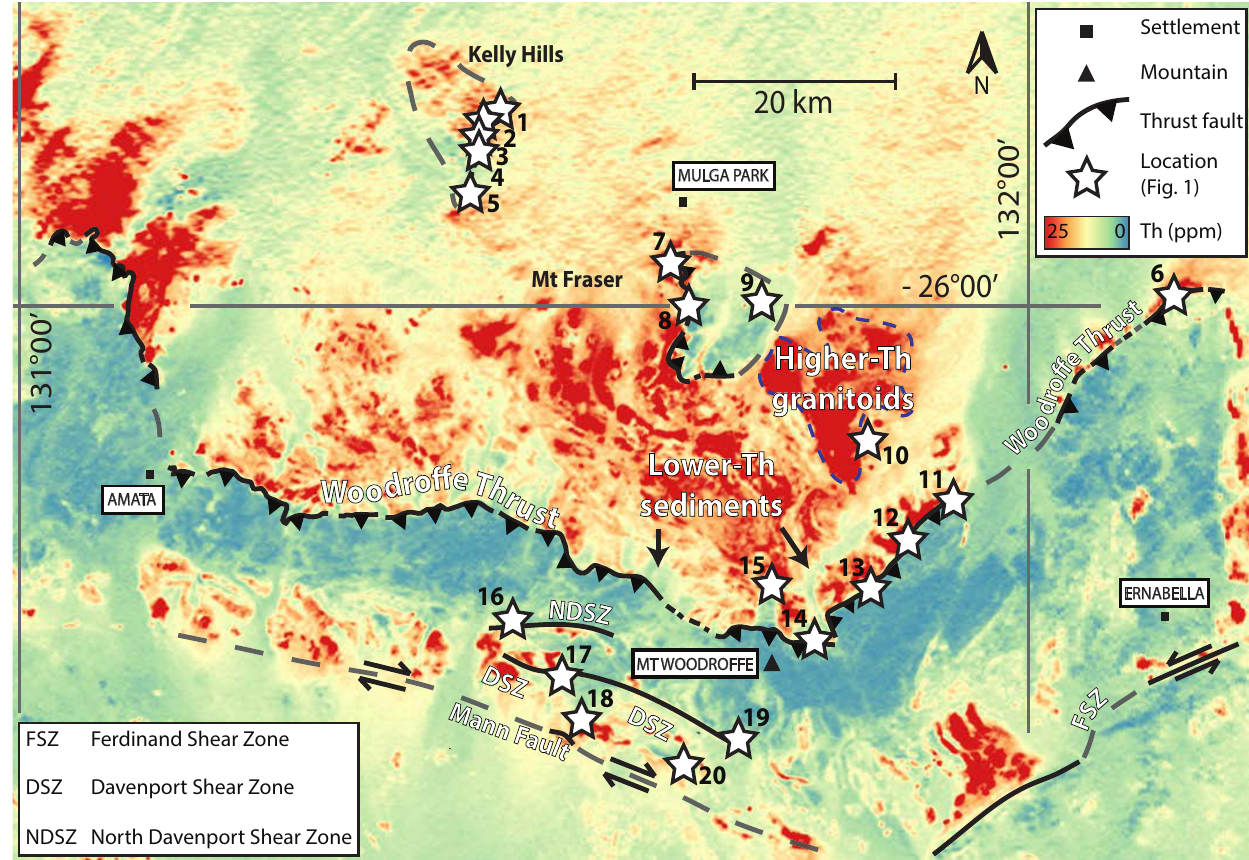
Figure 5. Airborne thorium (ppm) map of the central Musgrave Block. Data derived from the Australian Geophysical Archive Data Delivery System (GADDS) under http://www.ga.gov.au/gadds (last access: November 2013) (Percival, 2010). The hanging wall Fregon Subdomain is generally depleted compared to the footwall Mulga Park Subdomain. Granitoid intrusives of the Pitjantjatjara Supersuite often have a higher thorium content, particularly in the footwall (one example surrounded by the blue dashed line) but also in the southern part of the hanging wall. Lower-thorium signatures forming diffuse tongues extending northward into the footwall are attributed to alluvial wash derived from the hanging wall. The distinction in thorium content is no longer evident for the northernmost klippe of the hanging wall in the Kelly Hills area (locations 1–5) and the northernmost part of the Mt Fraser klippe (location 7).